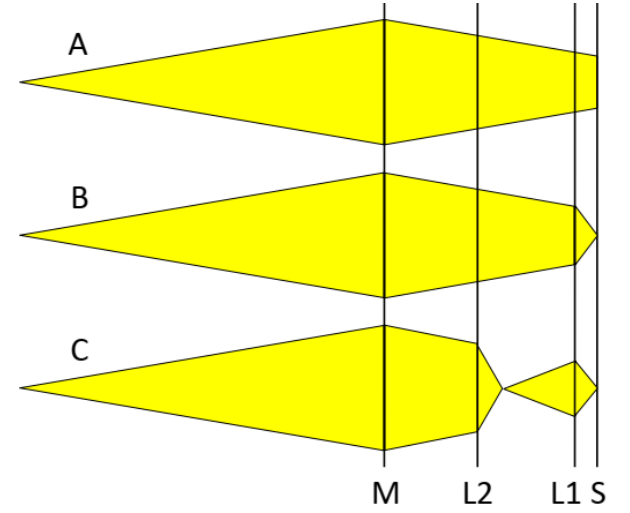
Figure 1. Operating modes A, B, and C, shown in the horizontal plane. M is a diamond monochromator crystal with Laue focusing, S is the sample position. L1 is the primary focusing lens. L2 is the secondary focusing lens creating a virtual source point for L1 in configuration C.